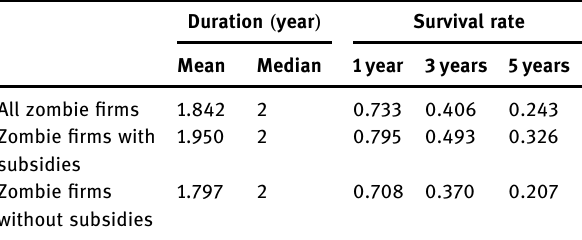
Table 2: Estimation of the duration of zombie fi rms prior to